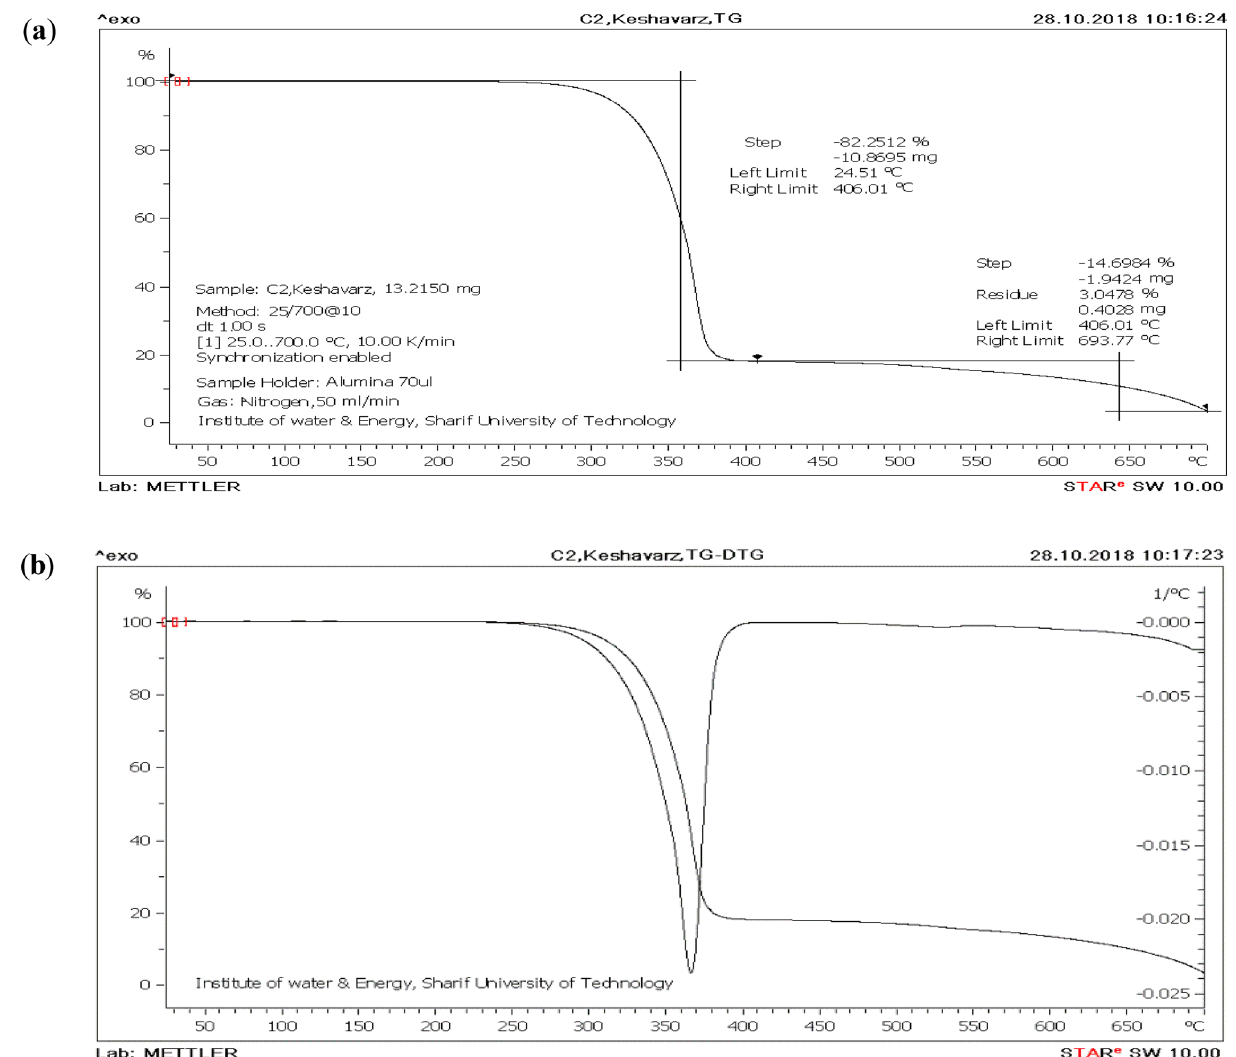
Figure 5. TGA ( a ) and TG-DTG curves of the Melamine@TMG organocatalyst ( 1 , b